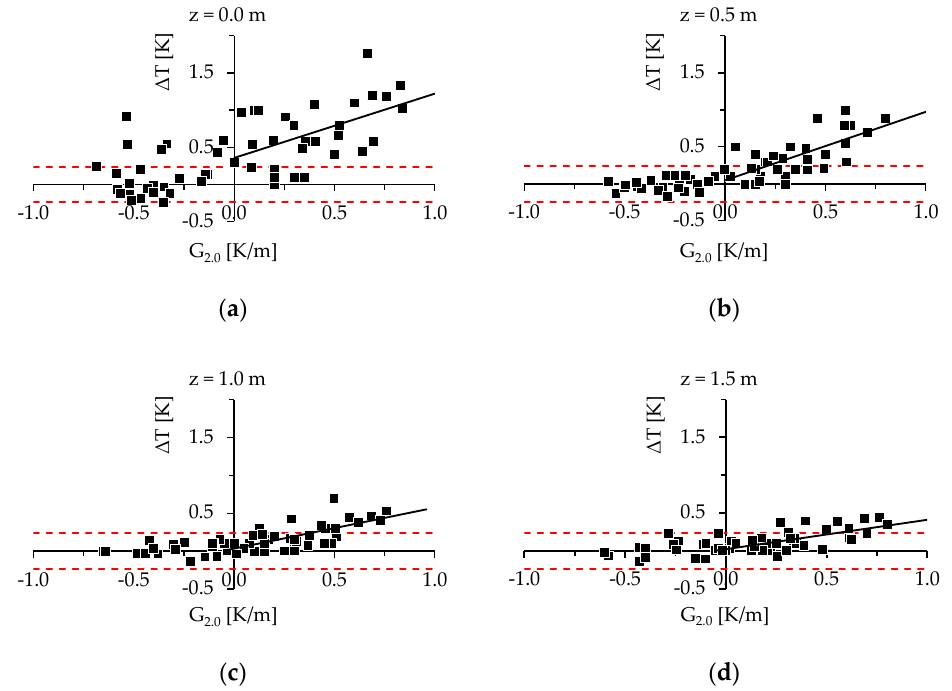
Figure 7. Correlation between ΔT and the thermal gradient interpolated over a distance of 2 m at a certain depth (G 2.0 ) and the linear regression for G 2.0 ≥ 0.0 m/K; ( a ) z = 0.0 m; ( b ) z = 0.5 m; ( c ) z = 1.0 m; ( d ) z = 1.5 m. The area bounded by the dashed red lines represents the measurement accuracy of the TLC- meter (ΔT ≤ 0.2 K). Temperature differences outside of the dashed lines are considered significant.